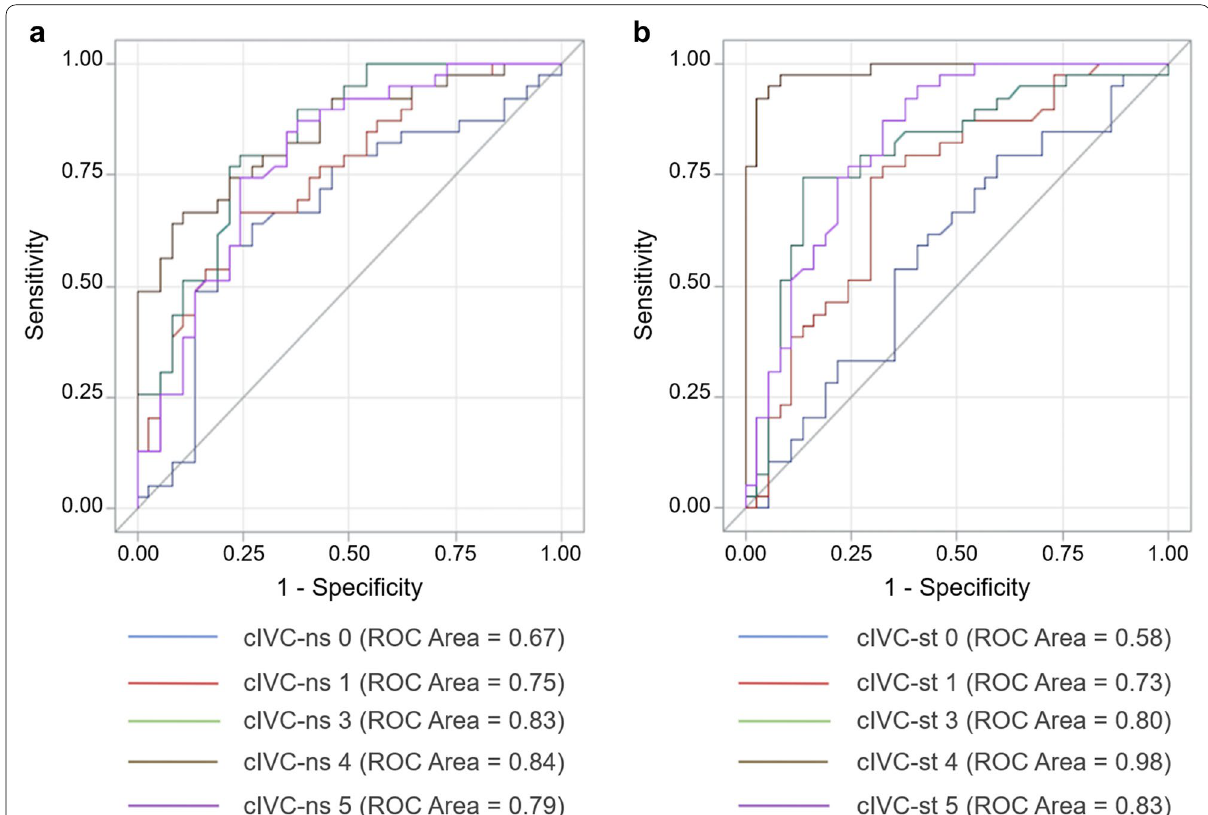
Fig. 2 Area under the receiver operating characteristic (ROC) curves to predict fluid responsiveness . Area under the ROC curves of the collapsibility index of the inferior vena cava (cIVC) to predict fluid responsiveness depending on the measurement site without ( a , cIVC-ns), and with ( b , cIVC-st) a standardized breathing manoeuvre. Measurement of inferior vena cava (IVC) diameters was carried out at five sites: at the IVC–right atrium junction (site 0), then at 1 (site 1), 3 (site 3), 4 (site 4) and 5 cm (site 5) caudal to the IVC–atrial junction. For each site where a difference was found